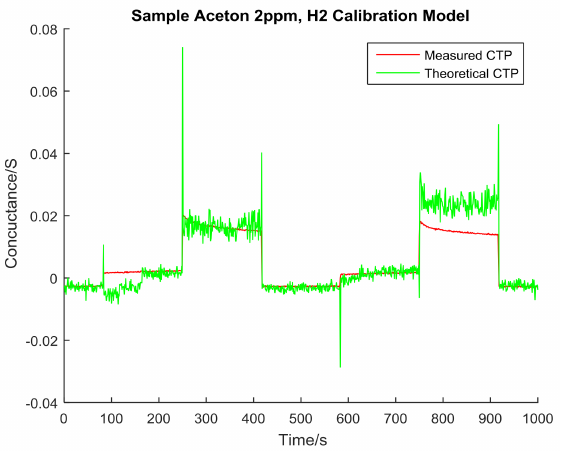
Figure 6. Comparison of measured CTP of an acetone sample and the related theoretical CTP based on the acetone calibration